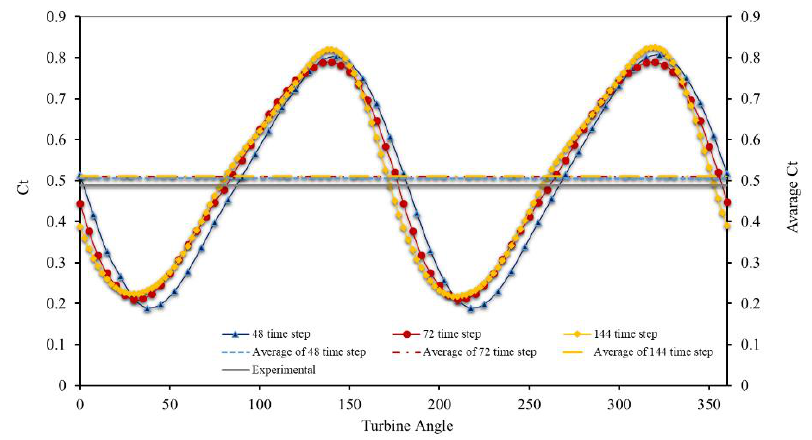
Figure 4. Time-step independence. Figure 4. Time-step